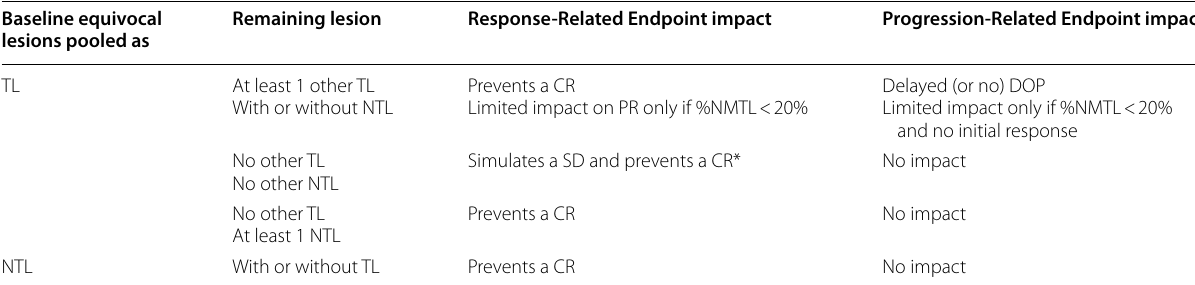
Table 3 Impacts of non-malignant lesion selection within TL or NTL group according to the primary endpoint captured by the